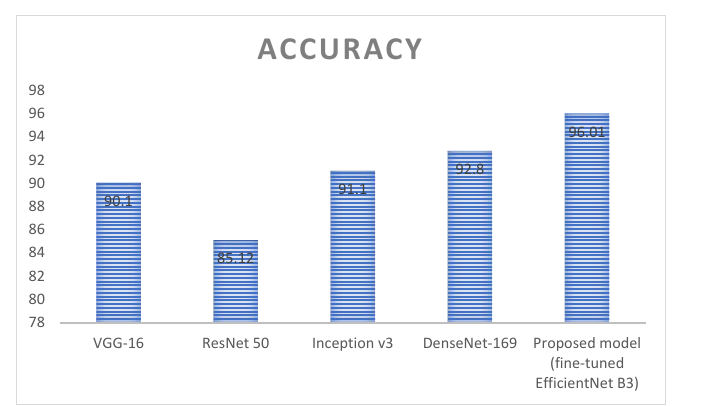
Figure 13. Analysis of accuracy value for the deep learning algorithms. Figure 14 represents the analysis of recall value for deep learning algorithms; here, four different algorithms are taken, namely, VGG-16, ResNet 50, inception v3, and Dense- Net 169. These algorithms are kept as a benchmark and compared with the proposed method called fine-tuned EfficientNet B3. VGG 16 obtained a recall value around 85.1%, ResNet 50 obtained a recall value around 85.12%, Inception v3 obtained a recall value around 84.1, and DenseNet 169 obtained a recall value around 90.8%. Here, the proposed method obtained a higher accuracy (around 96.01), which is higher compared with the remaining approach. Table 7 represents the performance evaluation of monkeypox detec- tion.